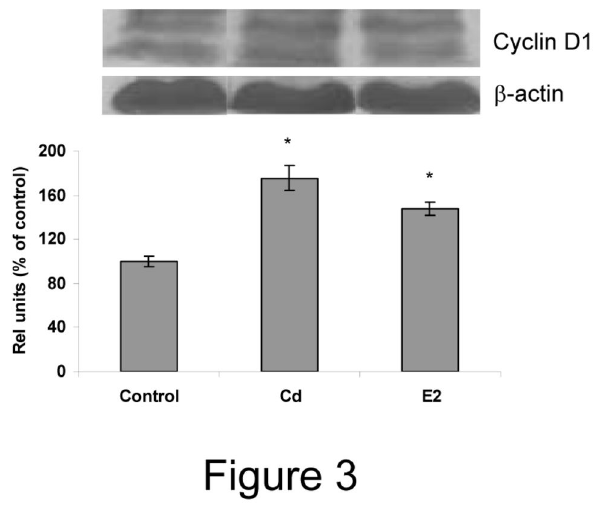
Figure 3. Cadmium increases cyclin D1 protein expression in anterior pituitary cells. Anterior pituitary cells were treated with vehicle (control), 10 nM Cd or 1 nM E2 for 72 h. A representative western blot is shown. Bars represent the mean ± SE of densitometric values normalized to β-actin expression and are expressed as percent of control. ANOVA followed by Tukey-Kramer’s test, *p<0.05 vs. control